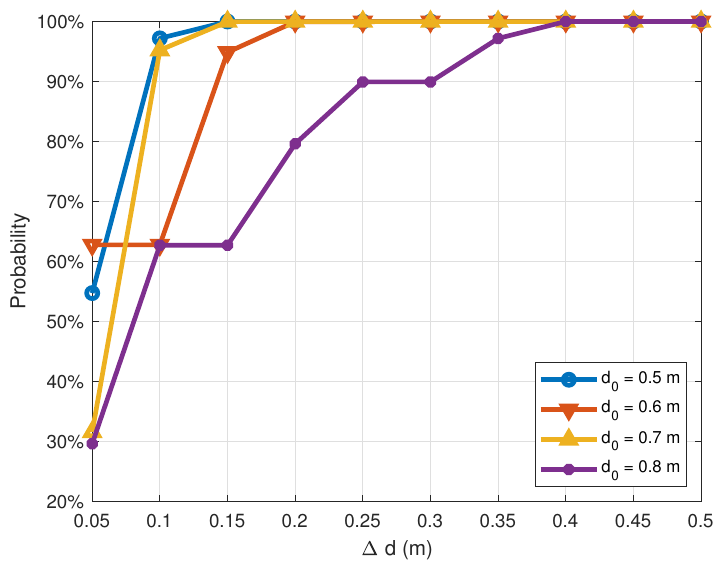
Figure 12. Cumulative distribution function of absolute distance error ∆ d at different